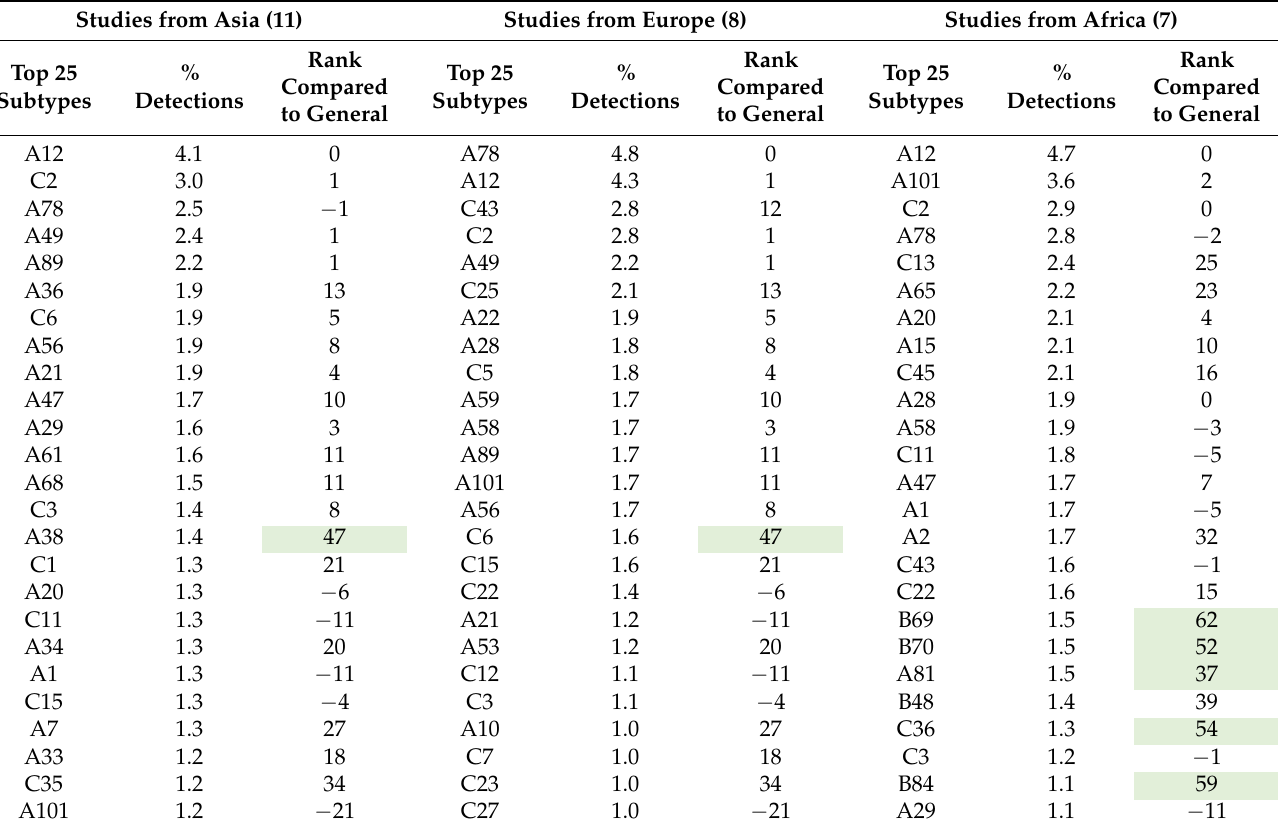
Table 1. Influence of geographical region on subtype rankings. Ranking of subtypes in the subset of studies was compared to the general ranking (31 studies). A positive number indicates that the sub- type is ranked higher in the analysis subset than in the general ranking. Subtypes gaining more than 40 ranks are highlighted in green. Number of studies in each subset is indicated between brackets.